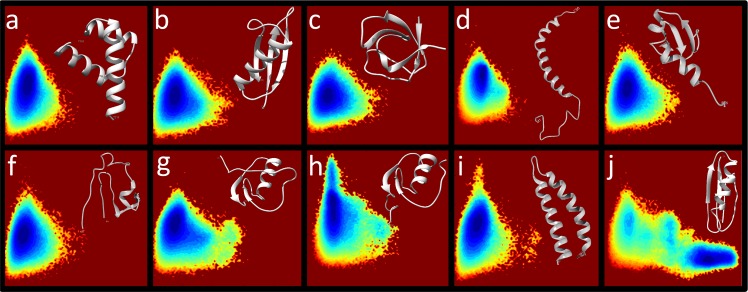
Control simulations of decoy sequences.Free energy as a function of QA and QB of various non-GA/GB sequences each with the same number of 56 residues were simulated using a hybrid potential that combines the GA/GB SBM and a sequence-dependent transferrable component for the given sequence. The free energy landscapes are plotted in the same style as that in Fig 3a. PDB structures are depicted as ribbon diagrams. (a) Hox11L1 homeodomain (PDB:3A03). (b) 50S ribosomal protein LX (PDB:4V9F, chain 6). (c) Grb2 SH3C domain (PDB:2VVK). (d) Peripheral stalk subunit H of the methanogenic A1AO ATP synthase (PDB:2K6I). (e) N-terminal domain of ribosomal protein L9 (PDB:1CQU). (f) Rubredoxin type protein from Mycobacterium ulcerans (PDB:2M4Y). (g) Pancreatic secretory trypsin inhibitor (Kazal type) variant 3 (PDB:1HPT). (h) Serine protease inhibitor infestin 4 (PDB:2ERW). (i) Ral binding domain of RLIP76 (PDB:2KWH). (j) Modified 56-residue version of protein L (PDB:2PTL; see Methods).